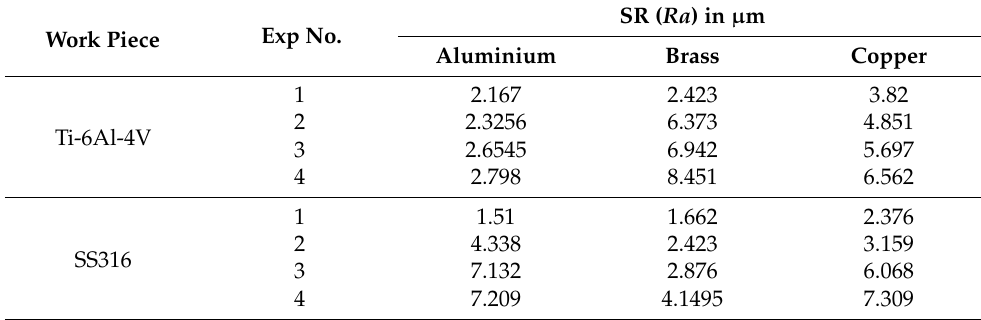
Table 8. The values of SR for different tool–work piece combinations for different experiments. Work